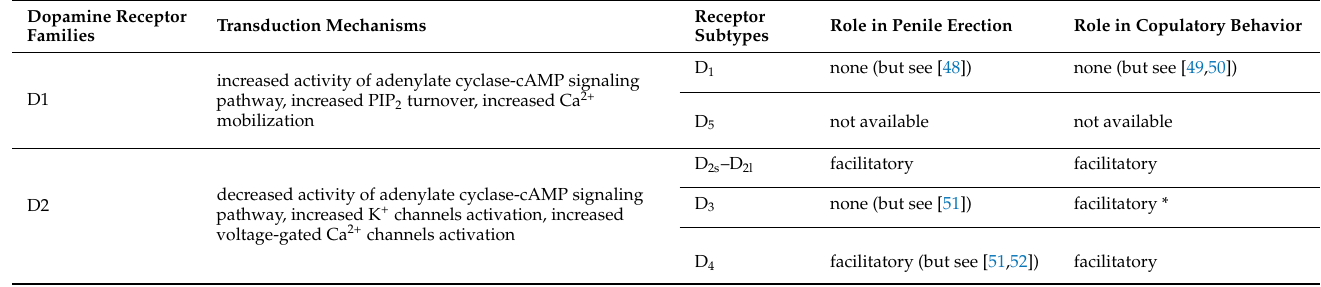
Table 2. Classification of dopamine receptors and their role in penile erection and copulatory behavior.